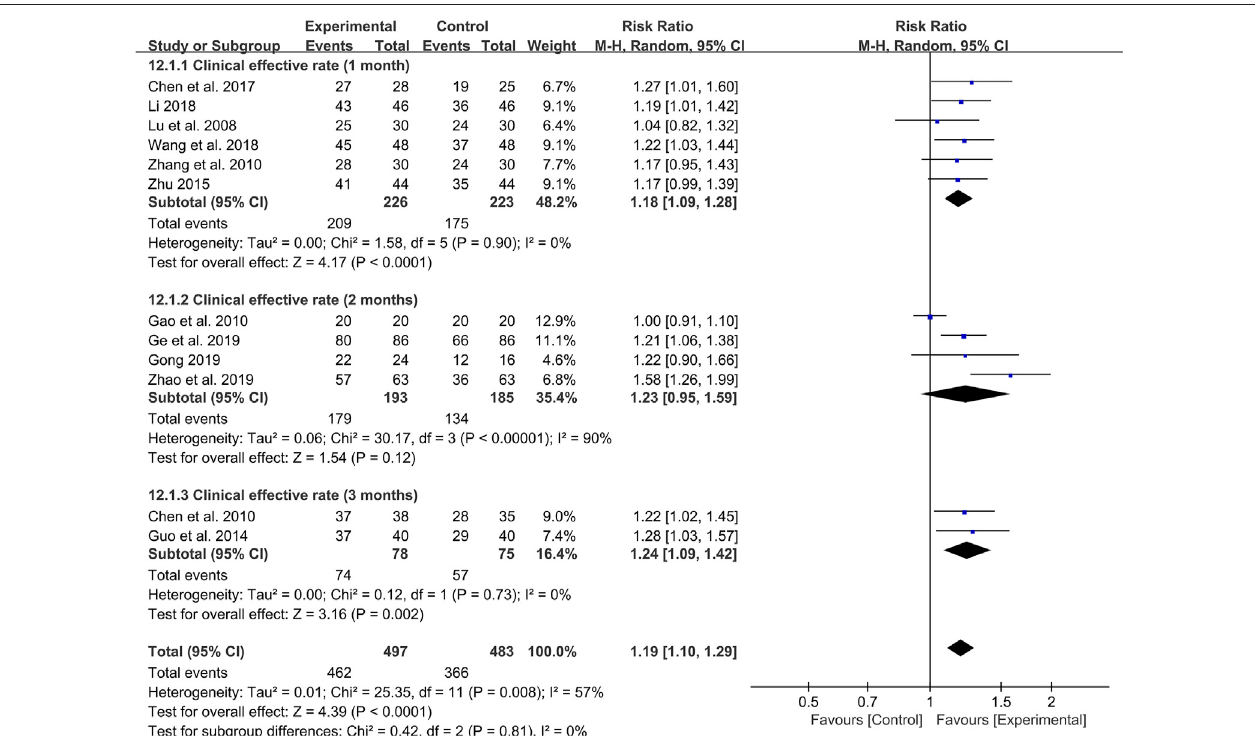
FIGURE 4 | Forest plot displaying the results of the meta-analysis for clinical effective rate in different course of treatment.